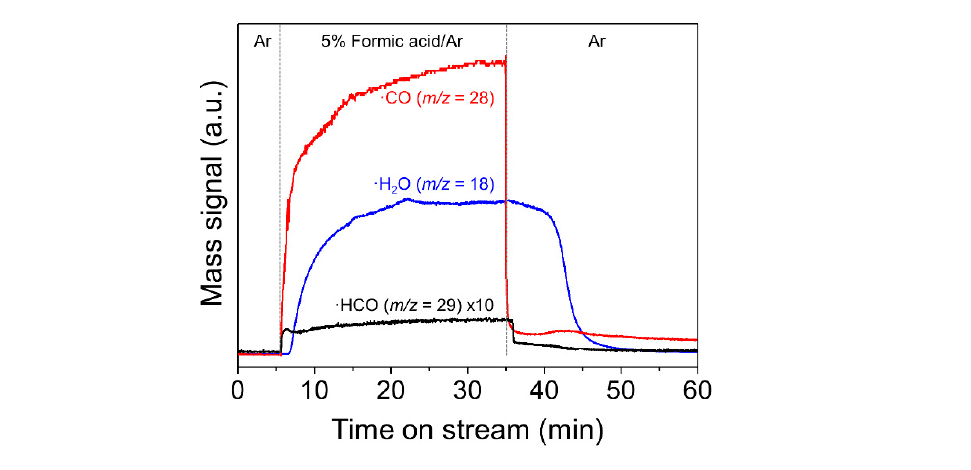
Figure S2: Pore size distribution of (a) 5SZ( y ) and (b) x SZ(600) catalysts calculated from the desorp- tion branch. Figure S3: Scanning electron microscope–energy-dispersive X-ray spectroscopy (SEM– EDS) images of 5SZ(600) catalyst. Figure S4: Thermogravimetric analysis profiles of (a) 5SZ( y ) and (b) x SZ(600) catalysts. Figure S5: SEM images of x SZ(600) catalysts. Figure S6: Evolution of ∙ NH ( m/z = 15), ∙ H 2 O ( m/z = 18), and SO 2 ( m/z = 64) in mass spectra as a function of temperature during tem- perature-programmed decomposition of as-prepared 10SZ (solid line) and calcined 10SZ(600) (dashed line) catalysts. Figure S7: FTIR spectra of (a) 5SZ( y ) and (b) x SZ(600) in the range of 2000– (b) x SZ(600) catalysts. Figure S9: Evolution of · CH 3 CO ( m/z = 43) and · C 3 H 5 ( m/z = 41) in mass 4000 cm − 1 . Figure S8: Deconvoluted O 1s XPS spectra for (a) 5SZ( y ) and (b) x SZ(600) catalysts. Figure spectra as a function of temperature during IPA-TPD of 0SZ(600). Figure S10: Formic acid conversion S9: Evolution of ∙ CH 3 CO ( m/z = 43) and ∙ C 3 H 5 ( m/z = 41) in mass spectra as a function of temperature as a function of time on stream over 10SZ( y ) catalysts at 260 ◦ C and 6.0 h − 1 during IPA-TPD of 0SZ(600). Figure S10: Formic acid conversion as a function of time on stream over 10SZ( y ) catalysts at 260 °C and 6.0 h − 1 WHSV.